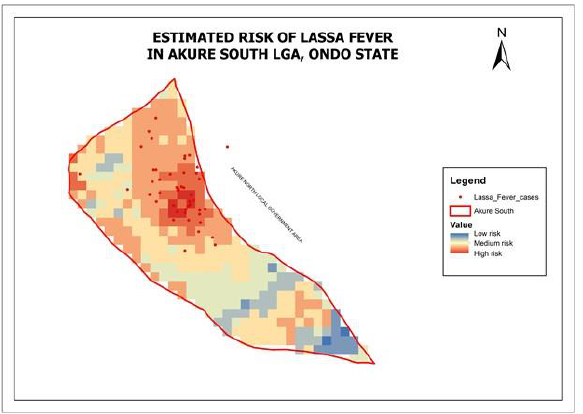
Figure 5. Showing estimation of risk: high risk areas (red) to low-risk areas (blue)